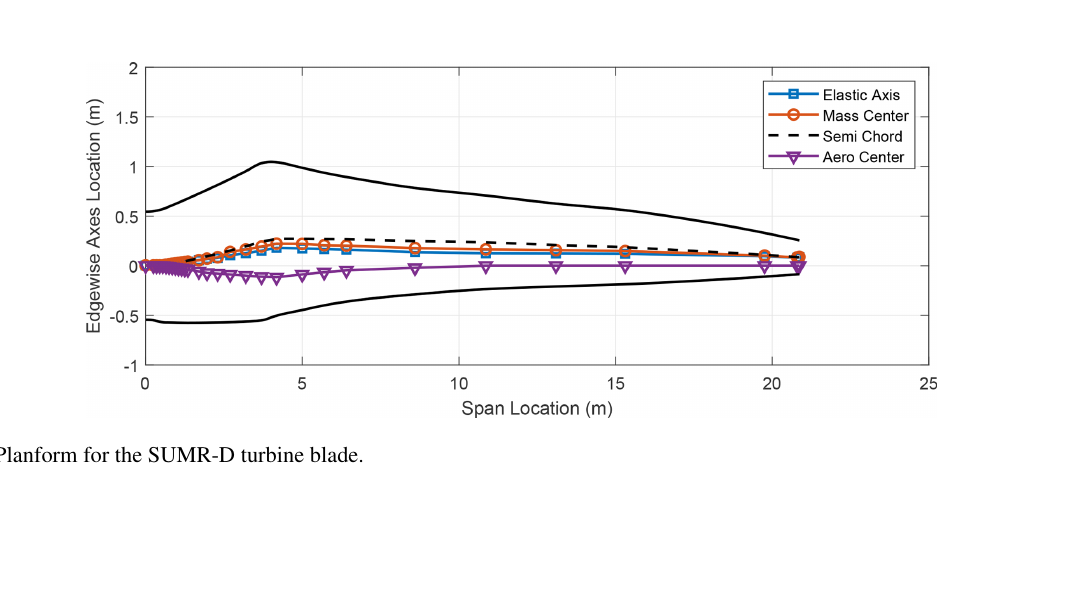
Figure A8. Planform for the UTD100-04 turbine blade.